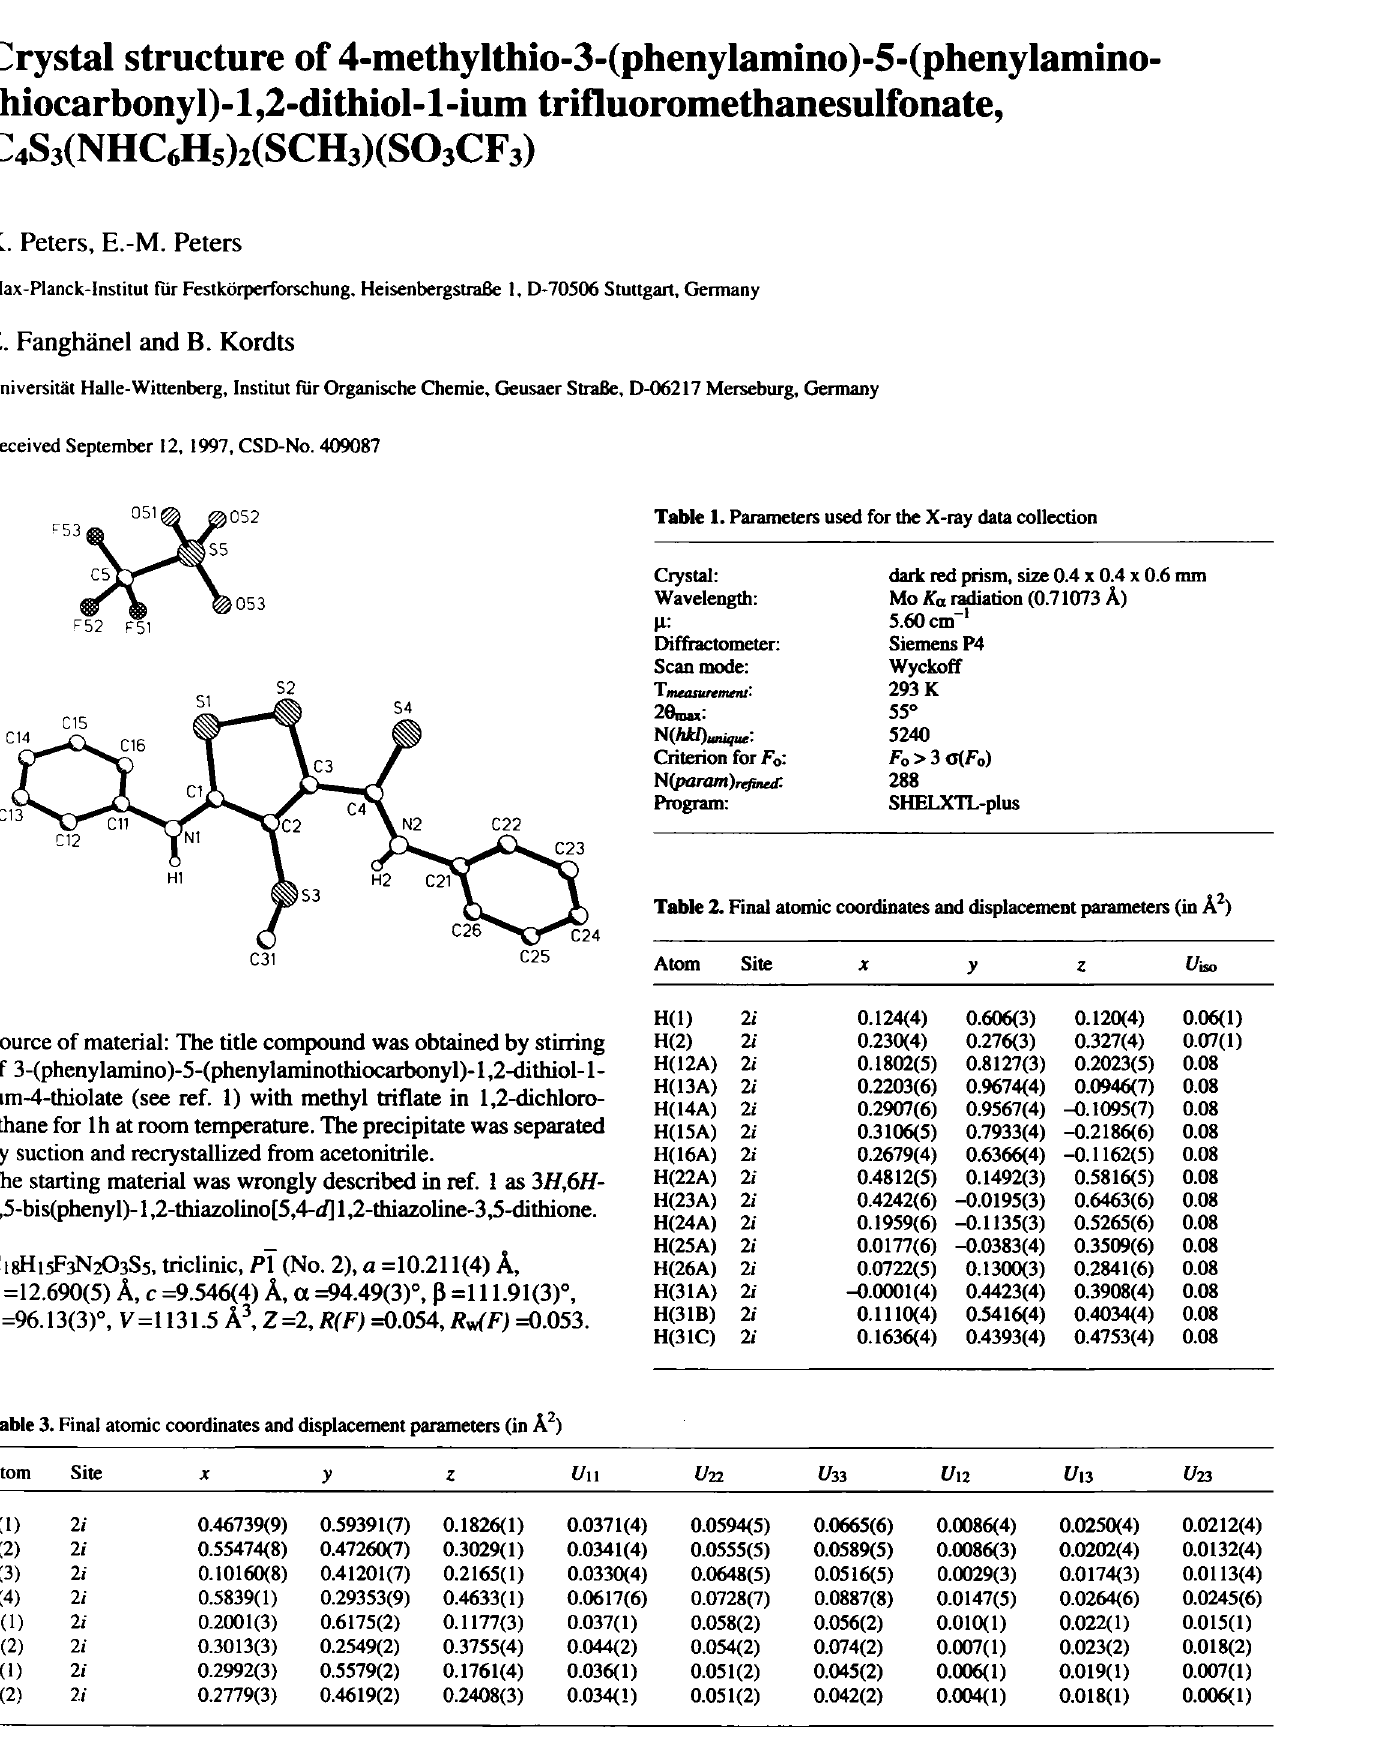
Table 1. Parameters used for the X-ray data collection